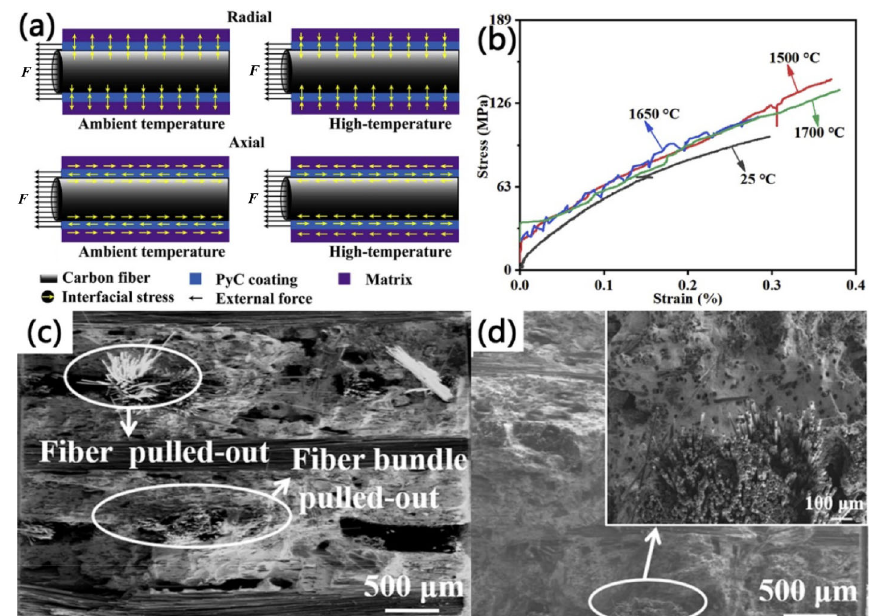
Fig. 22 Interphase stress distribution at ambient temperature and high temperature (a), stress–strain curves of C f /C–ZrC– SiC–ZrB 2 composites during tensile test at different temperatures (b), and fracture surfaces of C f /C–ZrC–SiC–ZrB 2 composites after tensile test at ambient temperature (c) and 1700 (d). ℃ Reproduced with permission from Ref. [263], © Elsevier B.V. 2019.